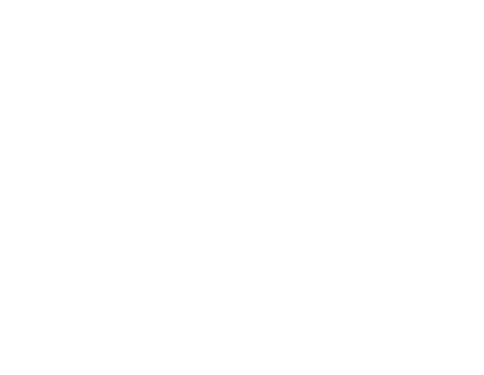
Figure 3. Reynolds numbers at the ( a ) inlets and ( b ) outlet.